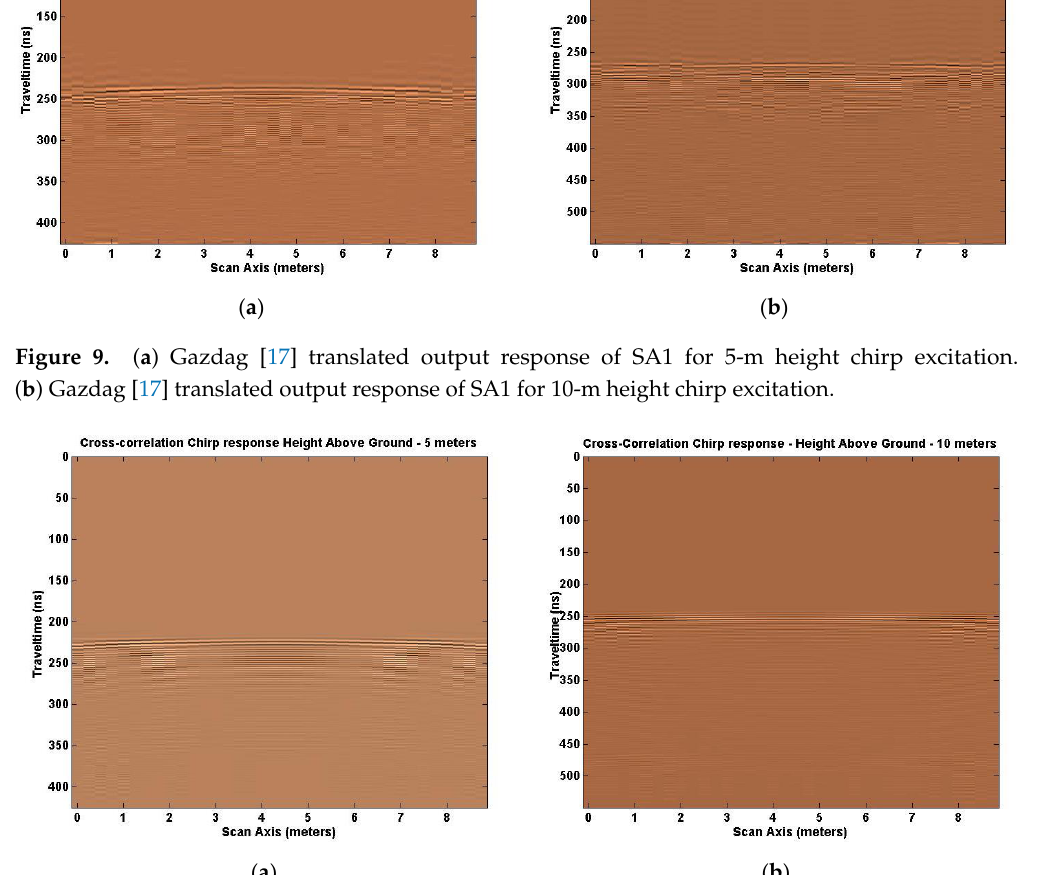
Figure 10. ( a ) Cross-correlation of chirp excitation response of SA1 model at 5-m height above ground. ( b ) Cross-correlation of chirp excitation response of SA1 model at 10-m height above ground.